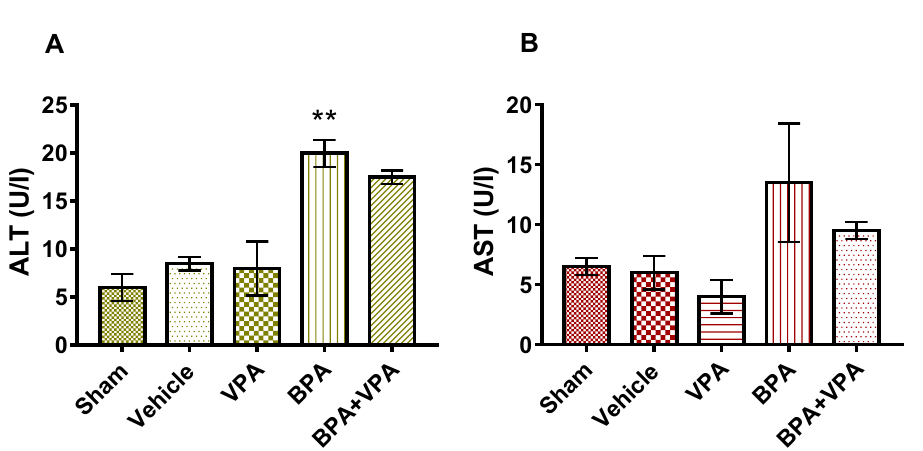
Figure 2. VPA decreased liver damage markers in the sera of BPA-exposed mice. ( A ) Measurement of ALT levels (U/I). ( B ) Measurement of AST levels (U/I). Data are represented as the mean ± SEM ( n = 6 per group). ** P < 0.01. VPA valproic acid, BPA bisphenol A, ALT alanine aminotransferase, AST aspartate aminotransferase, SEM standard error of the